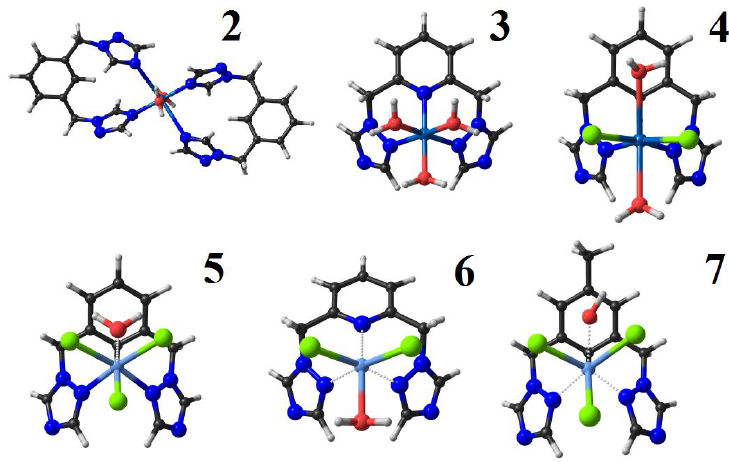
Figure 3. Optimized geometries for complexes 2 – 7 .